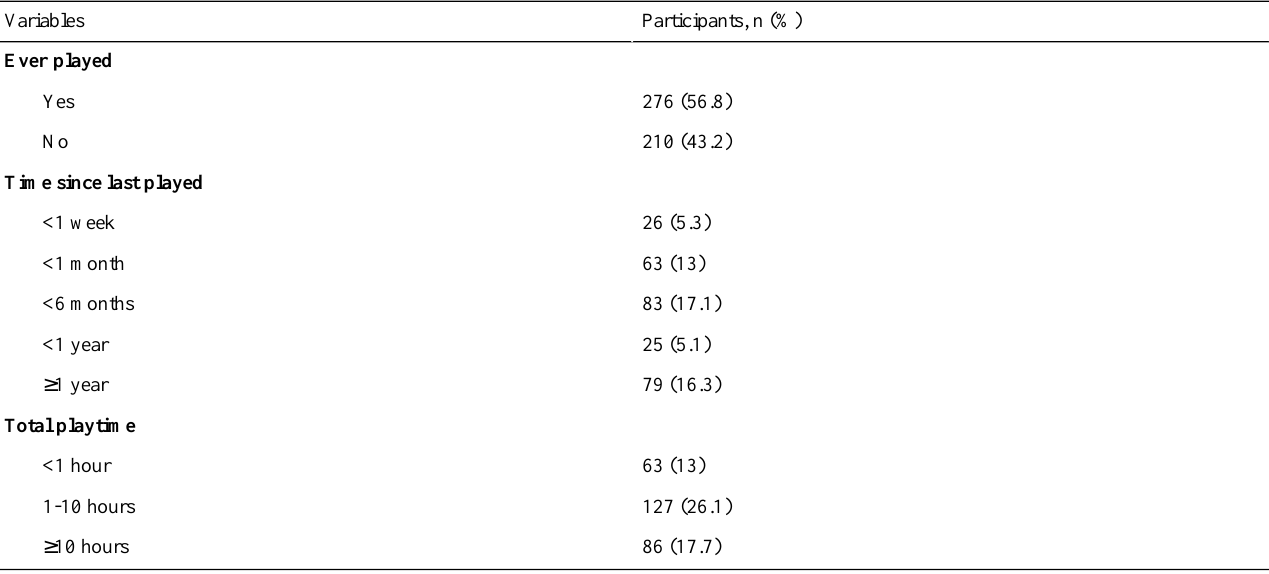
Table 3. Descriptive statistics regarding participants’game experience